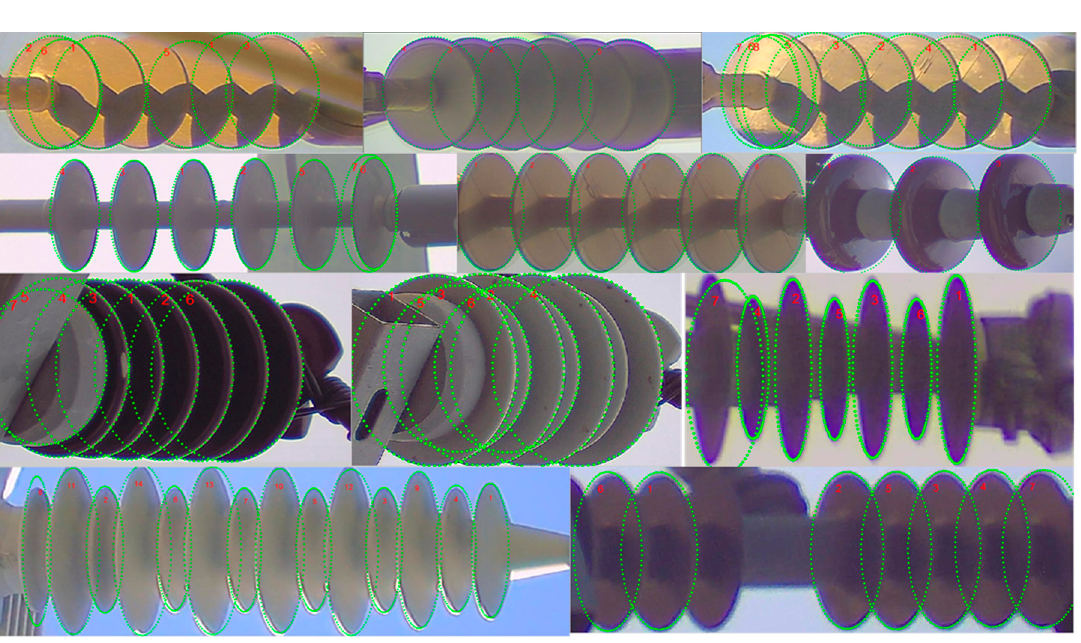
Figure 7. Results of the ellipse detection on different types of insulators. Green ellipses are the detected boundaries of the shed/caps. The ellipse detector makes use of repeating pattern in the insulator body and consequently less influenced by the noisy edges that are caused by shadow and overlapping shed/caps.